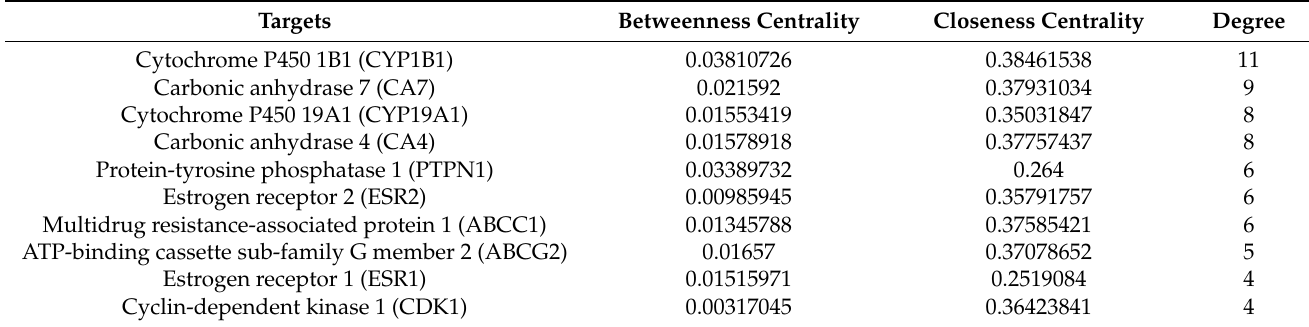
Table 3. Topological analysis of key targets of RSBDP against IBD (Top 10).